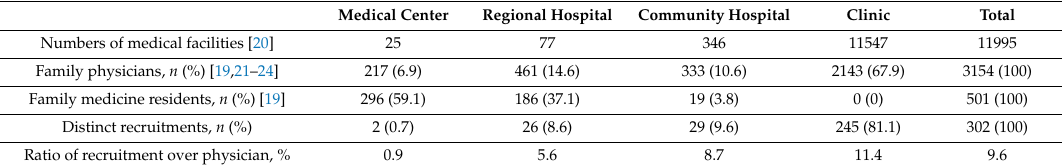
Table 2. Distribution of family physicians and recruitments by medical care facility accreditation level in